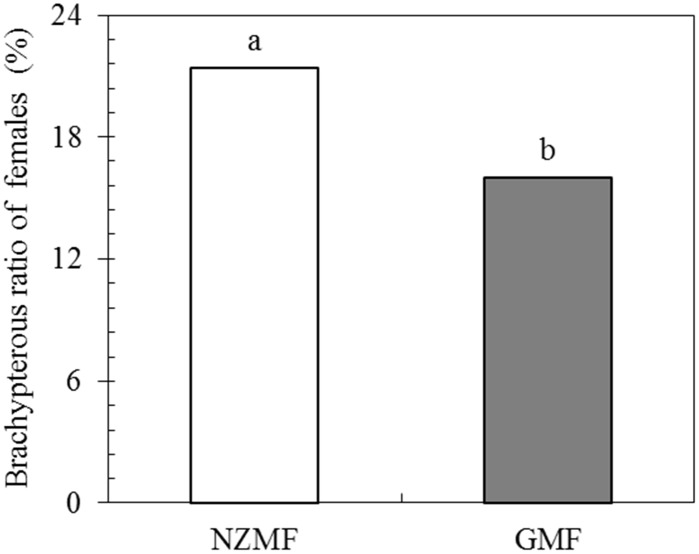
The percentage of brachypterous female adults of Sogatella furcifera produced under near-zero magnetic field (NZMF) vs. geomagnetic field (GMF).
Under NZMF, 452 and 123 individual newly emerged female adults were macropterous and brachypterous, respectively, whereas under GMF, 342 and 65 females were macropterous and brachypterous, respectively. Insects in both magnetic field treatments came from the same number of parents and were reared for one generation under either NZMF or GMF. Different lowercase letters showed significant differences between NZMF and GMF by the Chi-square test at P<0.05.